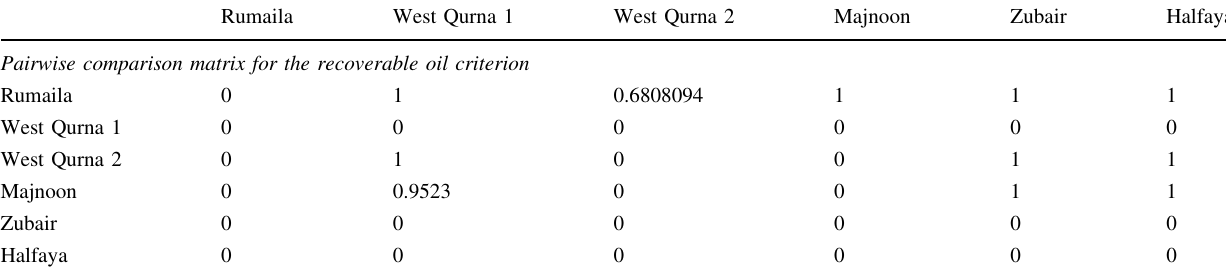
Table 9 PROMETHEE—unicriterion net flows